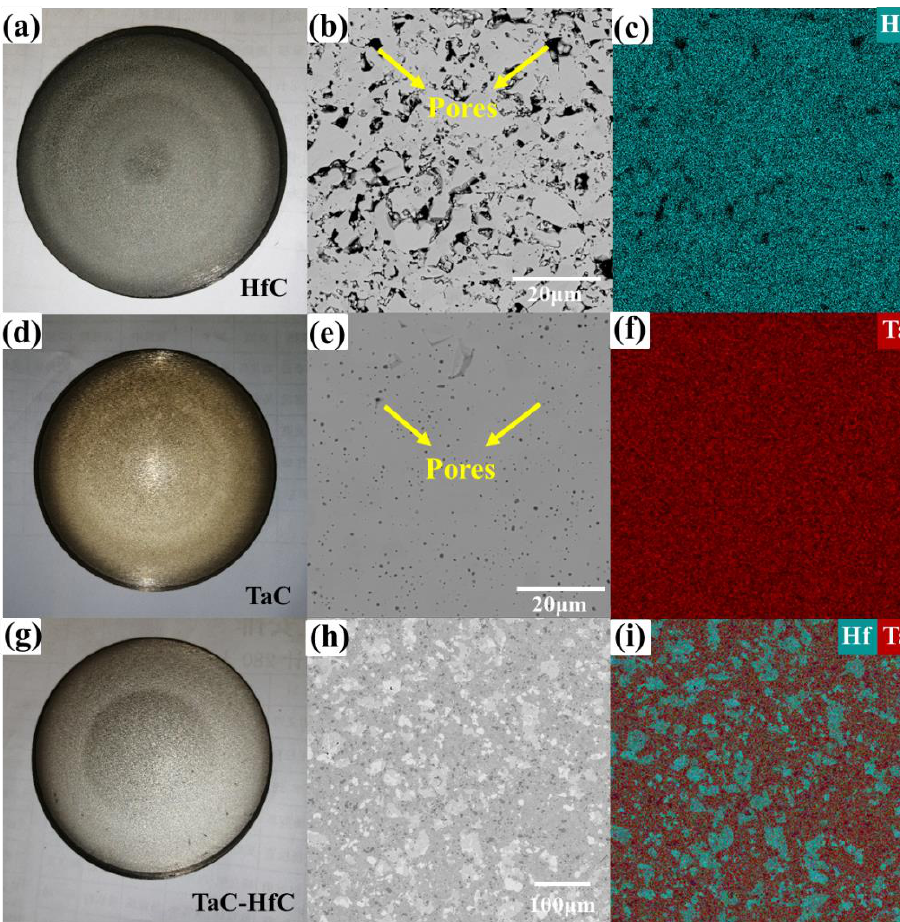
Figure 2. The optical images of the HfC ( a ), TaC ( d ), and TaC-HfC ( g ) target; the BSE images of surface morphology of HfC ( b ), TaC ( e ), and TaC-HfC ( h ); the corresponding EDS mapping results of HfC ( c ), TaC ( f ), and TaC-HfC ( i ).